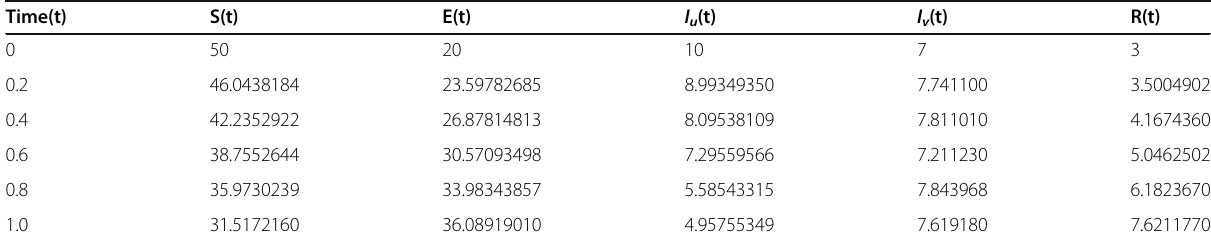
Table 4 Numerical results of the model system equations using DTM Time(t)